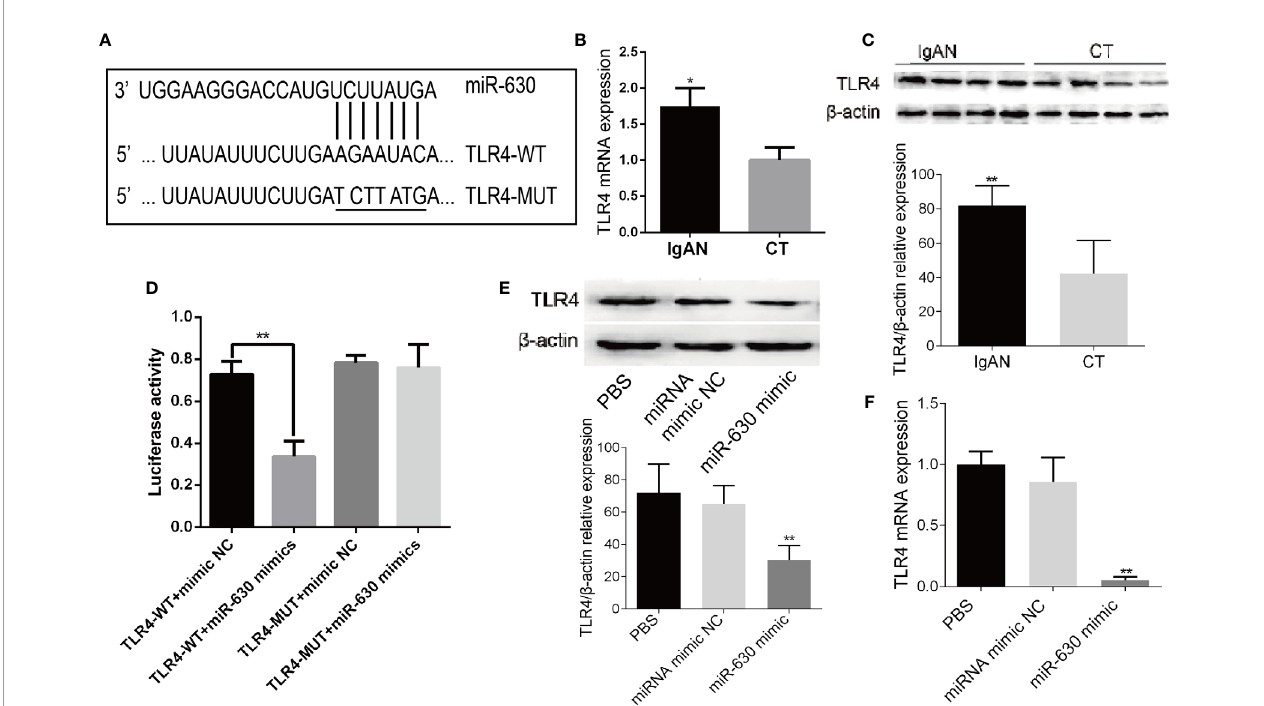
FIGURE 3 | TLR4 is the target gene of miR-630. (A) Bioinformatic analysis showed that the miR-630 putative target sites in TLR4 3 ’ -UTR. The mutated nucleotides were underlined. (B, C) qRT-PCR and western blot analysis detected the level of TLR4 mRNA and protein in the TMCs derived from the IgAN group and CT group, respectively. (D) The WT-TLR4 3 ’ -UTR and the MUT-TLR4 3 ’ -UTR reporters were co-transfected with miR-630 mimic or negative control into TMCs. Forty-eight hours after transfection, the luciferase activities were measured. (E, F) TMCs were transfected with negative miRNA mimics or miR-630 mimic respectively and harvested for the examination of TLR4 protein and messender RNA (mRNA) by qRT-PCR and western blot analysis. The data were expressed as mean ± SEM, *p < 0.05, **p < 0.01. IgAN, IgA nephropathy; CT, chronic tonsillitis. NC, negative